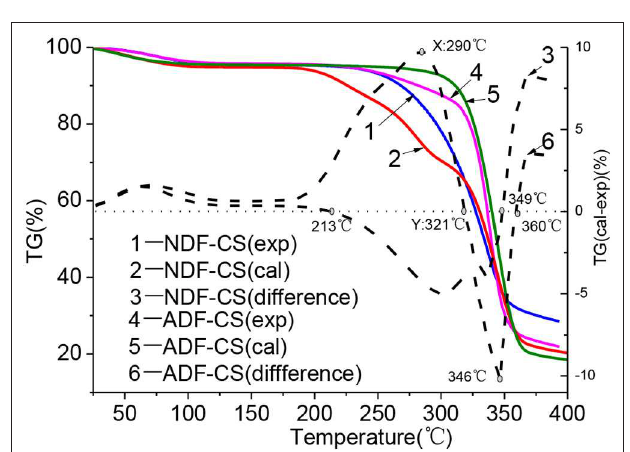
FIGURE 3 | Pyrolysis characteristic differences between experimental and calculated values of NDF-CS and ADF-CS.